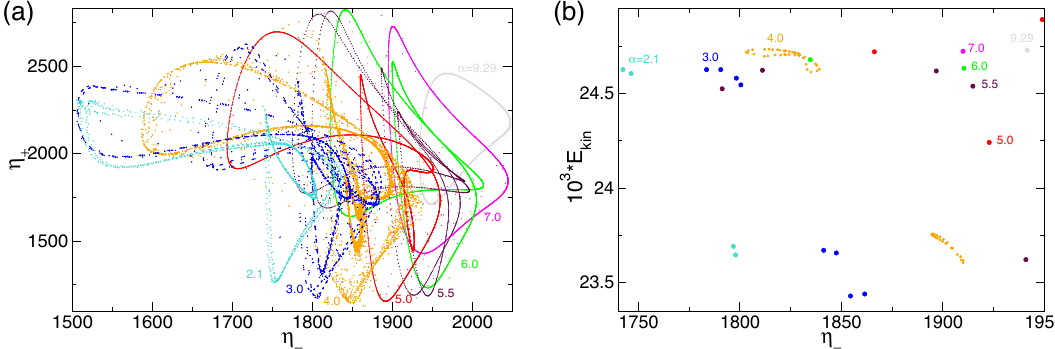
) and ( b ), the corresponding , η − + ) with η 1900 . Numbers in the figure identify the strength of + = −